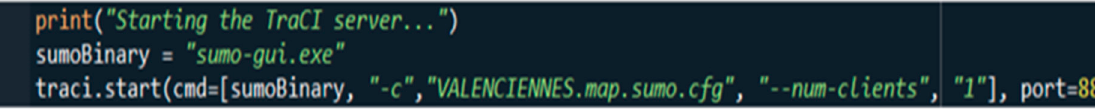
Figure 9. Traffic conditions data. ( a ) Traffic density ( b ) Traffic flow ( c ) Distance ( d ) Reference speed. 5.1. Illustrative Example After obtaining the traffic information, our second task was to implement it in our algorithm as input and launch the simulation on Matlab in order to obtain the optimal assignment of each vehicle. In our study, we chose the brand “Renault ZOE” with an au- tonomy of A i = 160 km and capacity of C i = 24 KWh: •